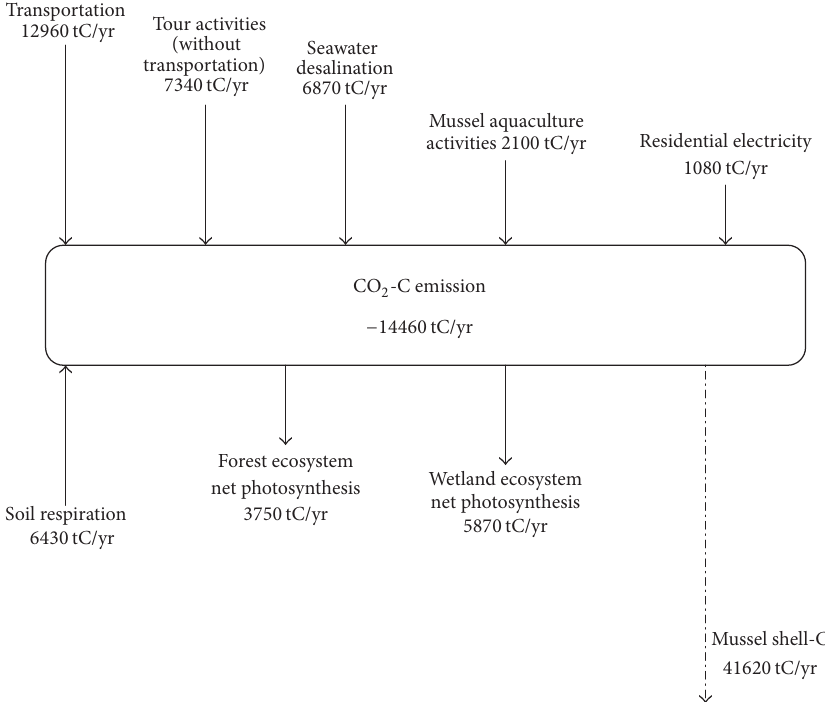
Figure 4: The carbon balance based on the results of the social-ecological process carbon cycle model on Gouqi